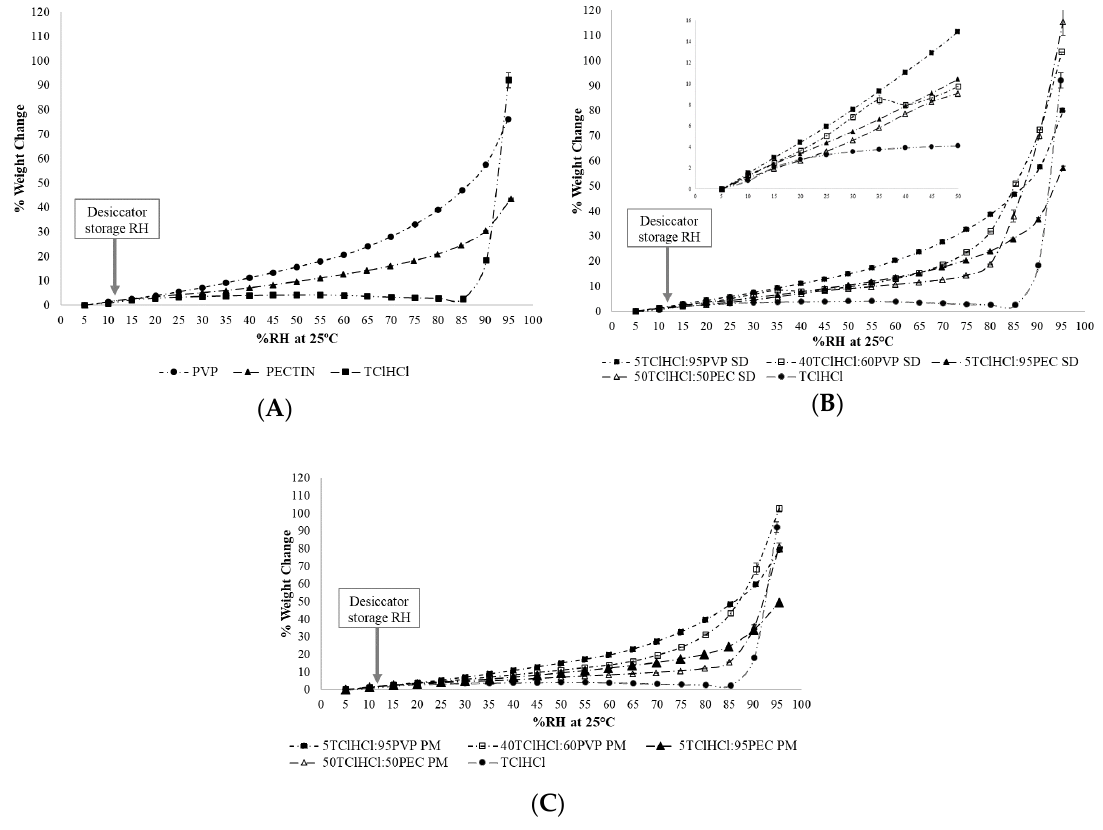
Figure 5. Moisture sorption profiles of ( A ) PVP, PEC, and TClHCl at 25 ◦ C; ( B ) TClHCl, 40TClHCl:60PVP, 5TClHCl:95PVP, 50TClHCl:50PEC, and 5TClHCl:95PEC solid dispersions (SDs) at 25 ◦ C, with insert graph highlighting initial moisture sorption di ff erences between SDs from 5–50% RH; and ( C ) 40TClHCl:60PVP, 5TClHCl:95PVP, 50TClHCl:50PEC, and 5TClHCl:95PEC physical mixtures (PMs) at 25 ◦ C. The arrows in the profiles identify 11% RH, the desiccator storage RH, indicating that the moisture contents of all samples were similar at the storage RH.